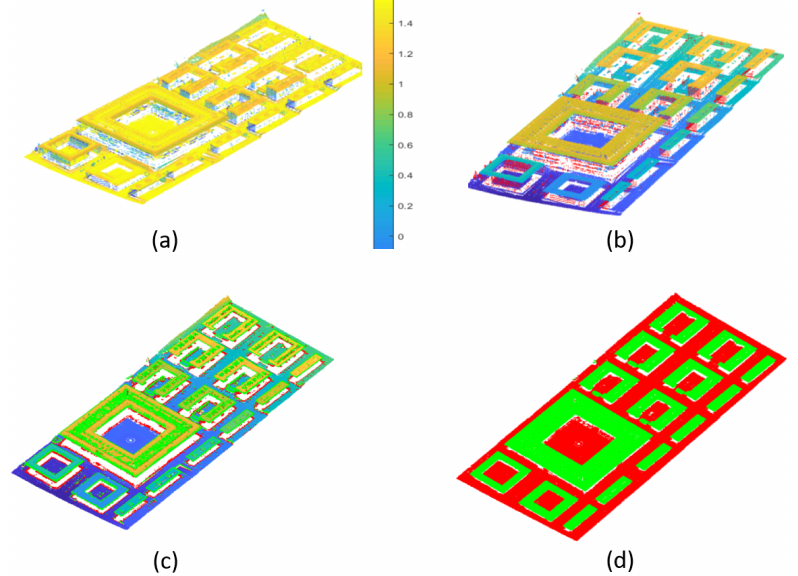
Figure 2. Point cloud classification. ( a ) Point cloud coloured by elevation. ( b ) Elevation-based filtering. Points that do not belong to roofs or to the ground are removed from the point cloud. ( c ) After performing the triangulation T Pp , two groups of points are labelled as either ground or roof. ( d ) A region growing algorithm classifies the complete point